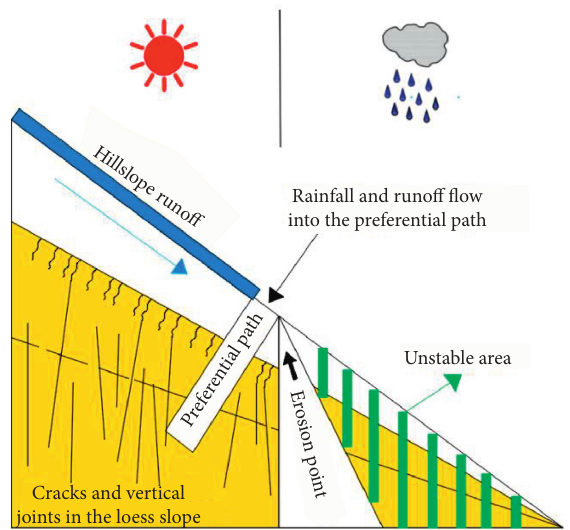
Figure 3: Diagram of rainfall and runoff flow into the preferential path created by cracks on the surface of slope.